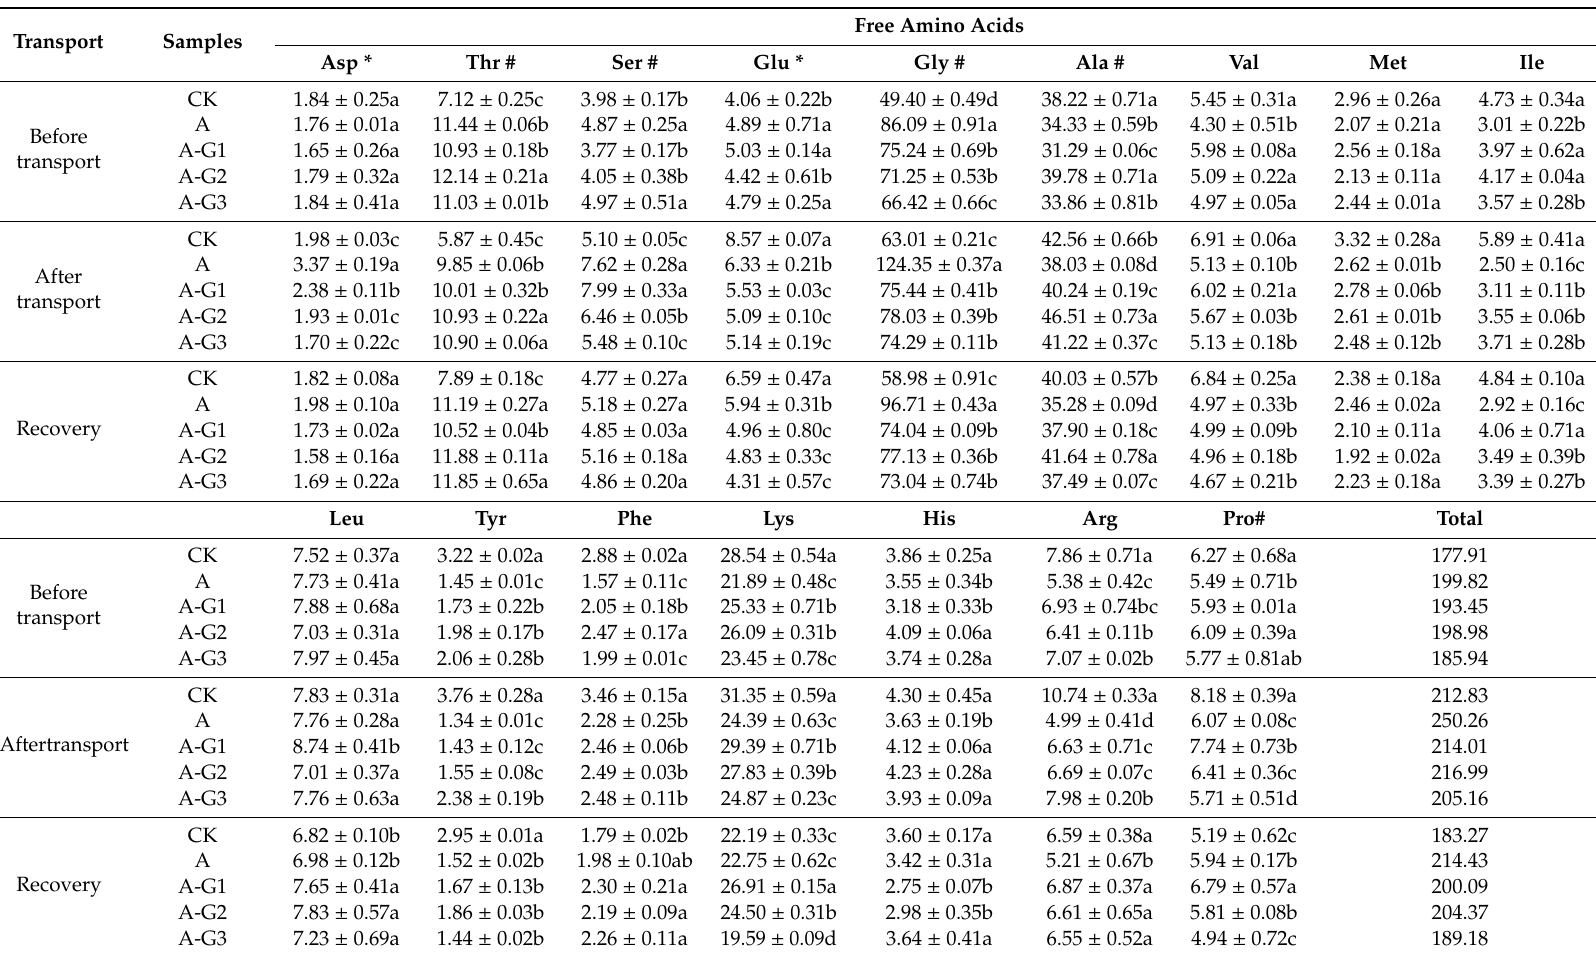
Table 5. E ff ect of ascorbic acid and β -1,3-glucan addition on the free amino acids of tiger grouper during simulated transport (mg / 100